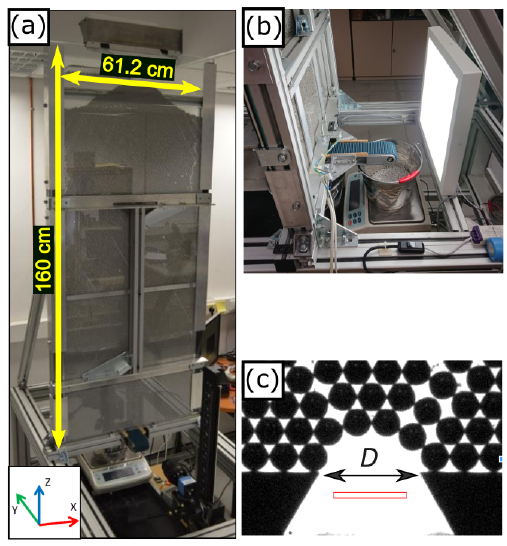
Figure 1. Photographs of the (a) front and (b) rear view of the experimental setup used in this work. (c) Monochrome image of an arch captured with the camera. The red rectangle is the area where the average value of the pixels is computed to detect the clogs and to calculate the avalanche